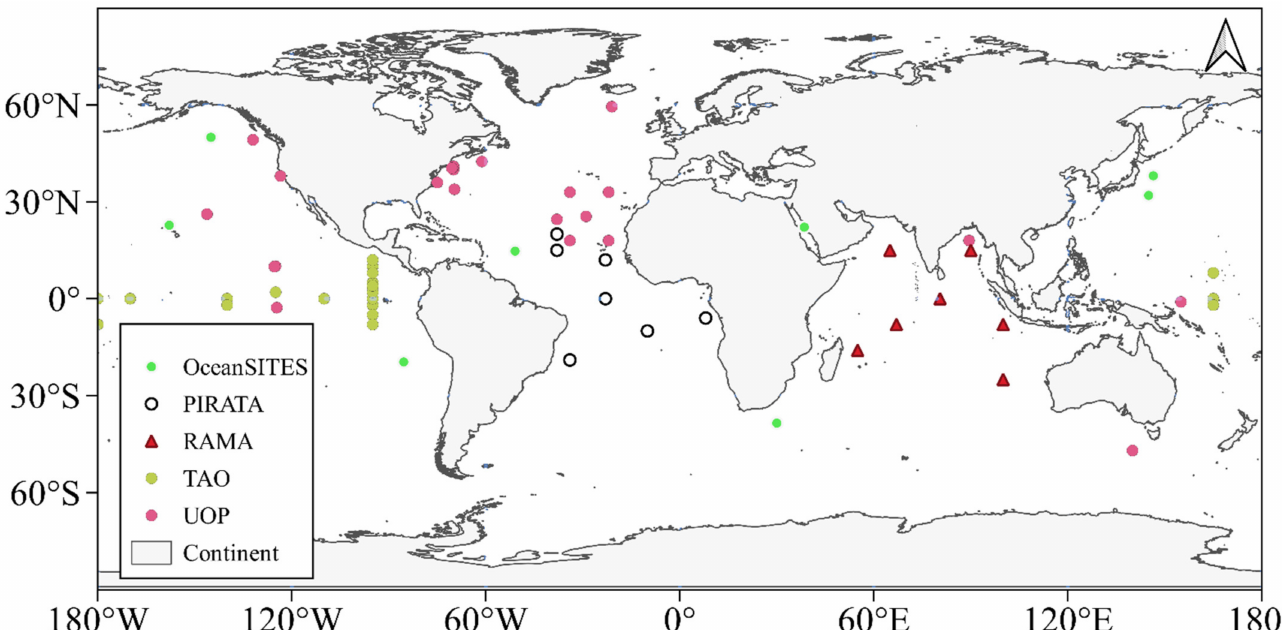
Figure 1. Spatial distribution of the 66 moored buoy sites from five observation